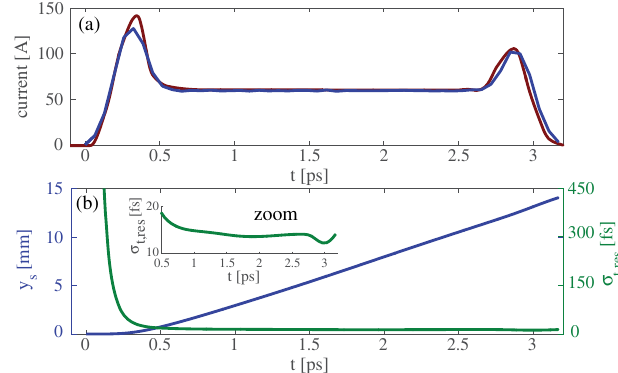
FIG. 2. (a) Initial bunch current distribution (blue) and recon- structed temporal profile (red). (b) Transverse displacement (blue) and resolution (green) at the screen as a function of the temporal coordinate.